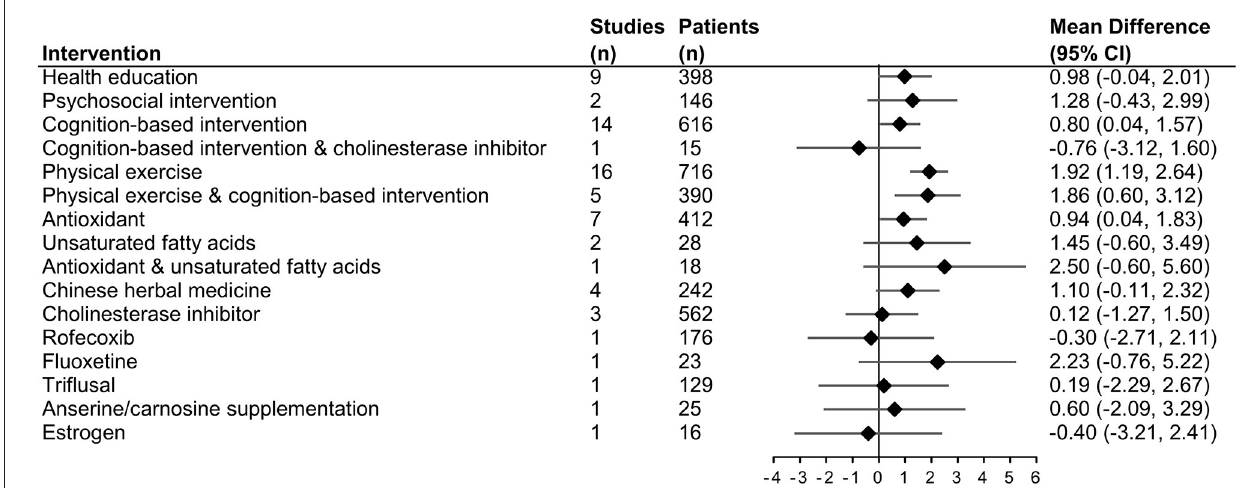
FIGURE 3 | Effect size for change in MMSE compared with control group using forest